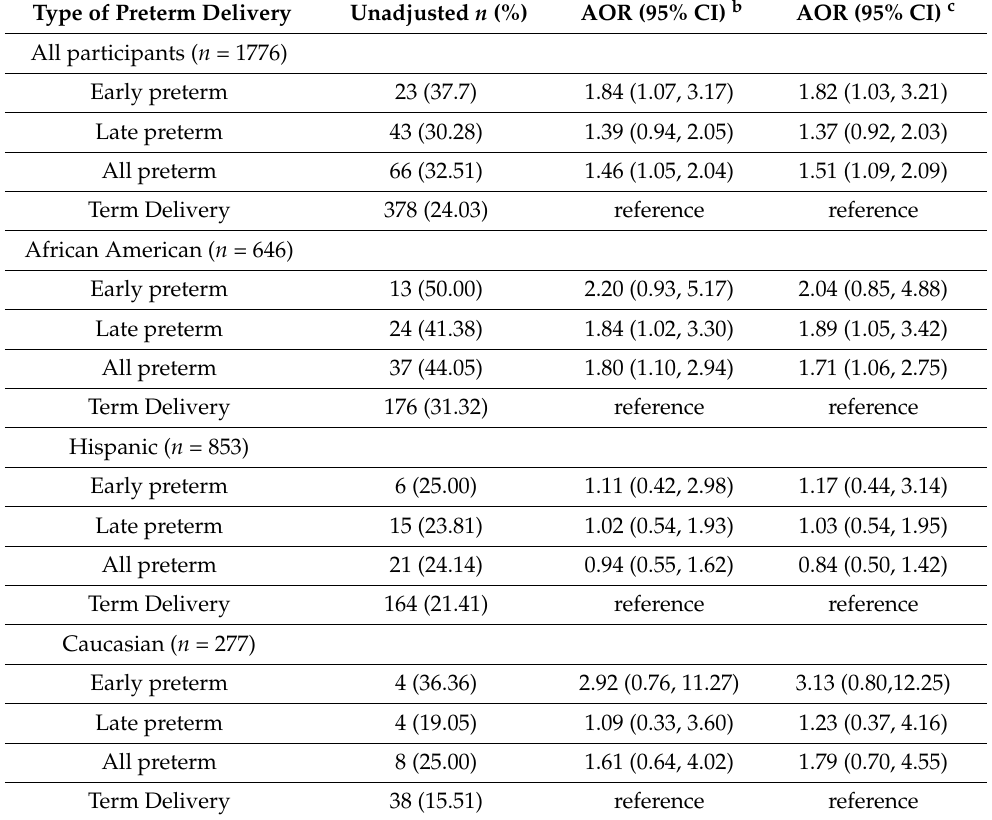
Table 4. Associations of decreased adiponectin level with preterm delivery by ethnicity a